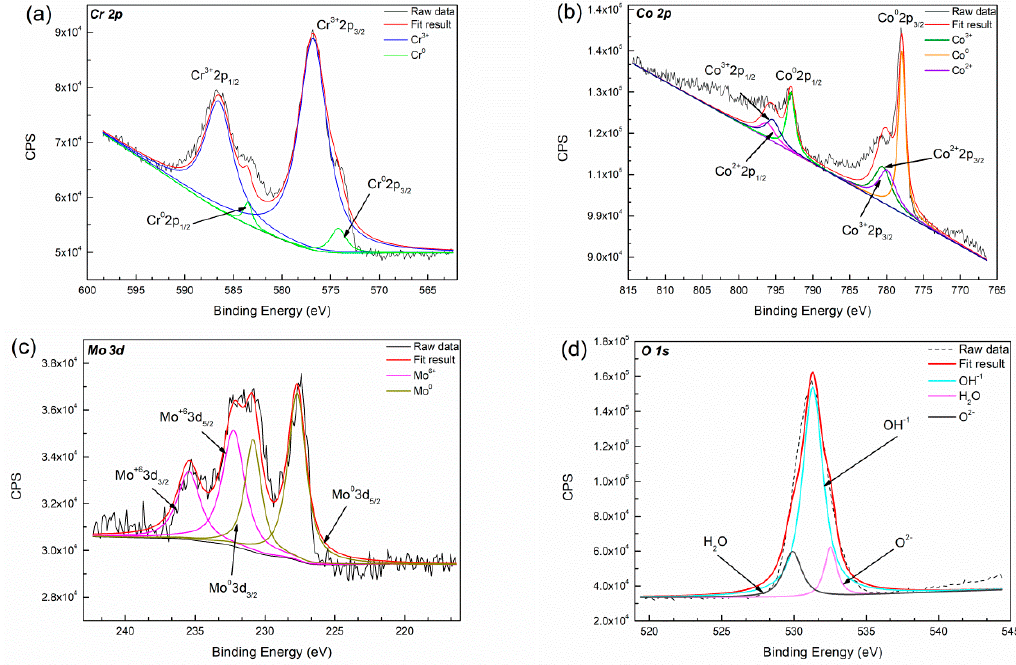
Figure 10. The X-ray photoelectron spectroscopy results of the specimen after immersion in